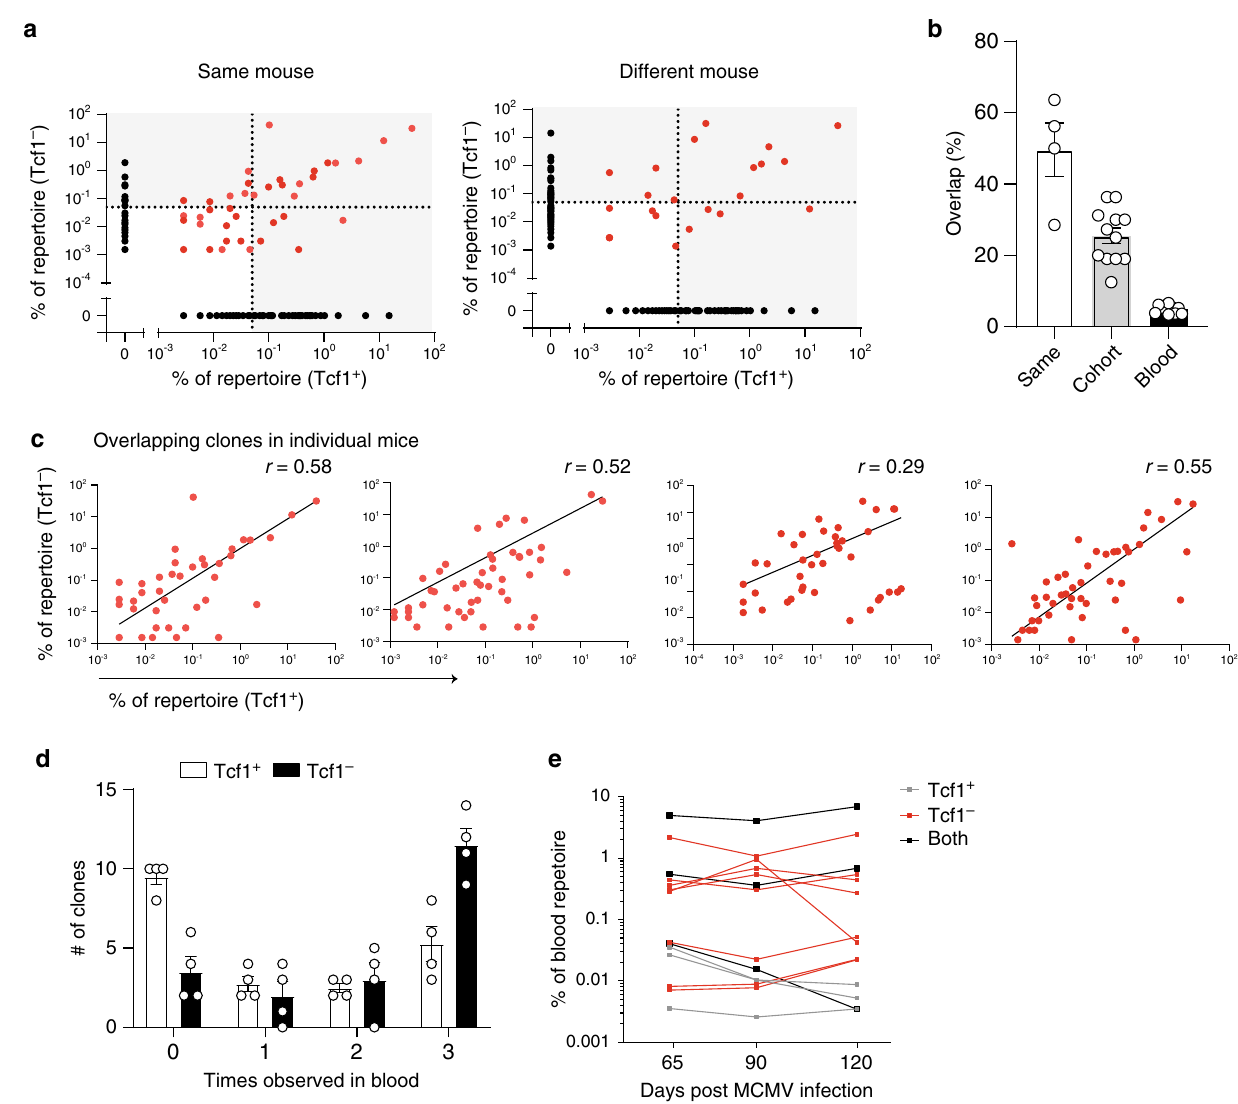
Fig. 7 Abundant Tcf1 + clones are found in the Tcf1 − population. a Plot indicates all unique clones, represented by a dot, in the M38-speci fi c Tcf1 + and the Tcf1 − population of the pooled repertoire (combined spleen, lungs and LNs). Black dots are only found in one compartment. Red dots indicate overlapping clones. Dotted line indicates the 0.5% threshold. Left plot shows the overlap of the Tcf1 + clones and the Tcf1 − clones within the same mouse. Right plot shows the overlap between the Tcf1 + from one mouse and Tcf1 − clones from a different mouse. b Bar graphs shows the percentage of Tcf1 − clones that is found within the Tcf1 + compartment compared to the same mouse or compared to a different mouse. Clones that were found above the threshold of 0.5% were included, indicated in the highlighted squares in A. Blood indicates the percentage of overlap of all unique clones between different mice at day 90 post-infection ( n = 4). c Plots show all overlapping clones found in both the M38-speci fi c Tcf1 + and the Tcf1 − population. Each dot represents a unique clone. Each plot represents one mouse, Spearman correlation is indicated. d The top 20 most expanded clones from the pooled organs were selected in both the M38-speci fi c Tcf1 + and the Tcf1 − population. Bar graphs shows how often these clones were detected across the three blood timepoints ( n = 4). e Representative plot of one mouse shows the clones that were found across all timepoints in the blood, as the frequency within the blood repertoire in time. Clones that were found in the top 20 of both the Tcf1 + and the Tcf1 − population are indicated in black. All bar graphs represent mean ± SEM, n = 4 mice per group. Source data are provided as a Source Data